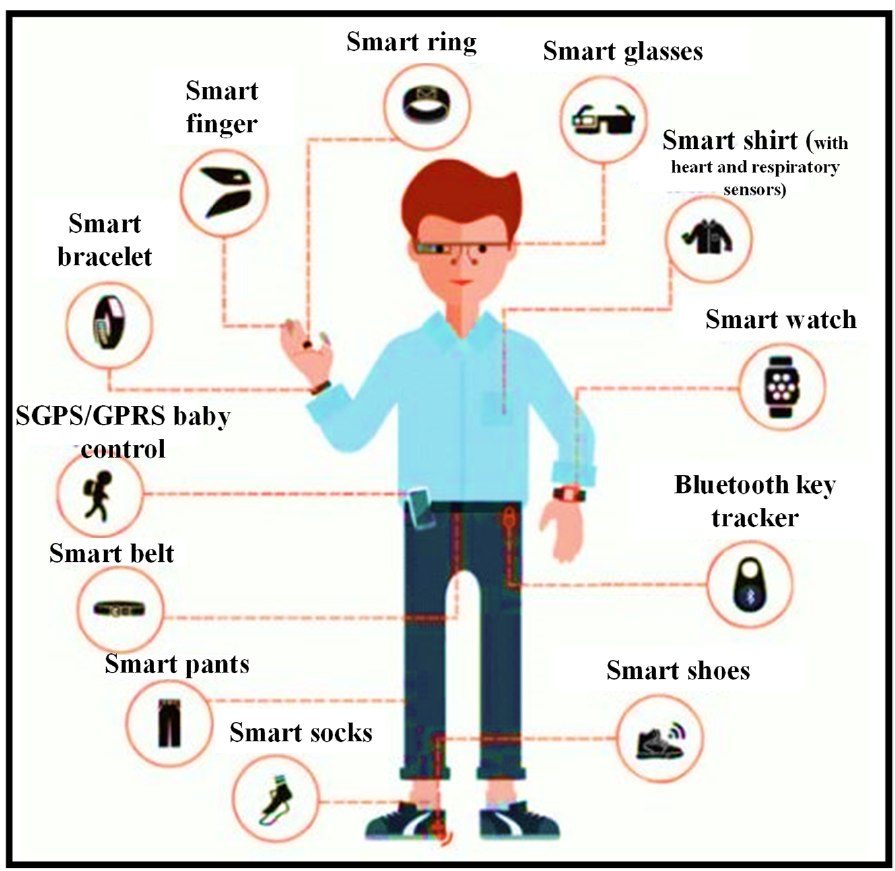
Figure 1. Wearable sensors can be worn almost anywhere on the body for daily activities, including health monitoring [12].